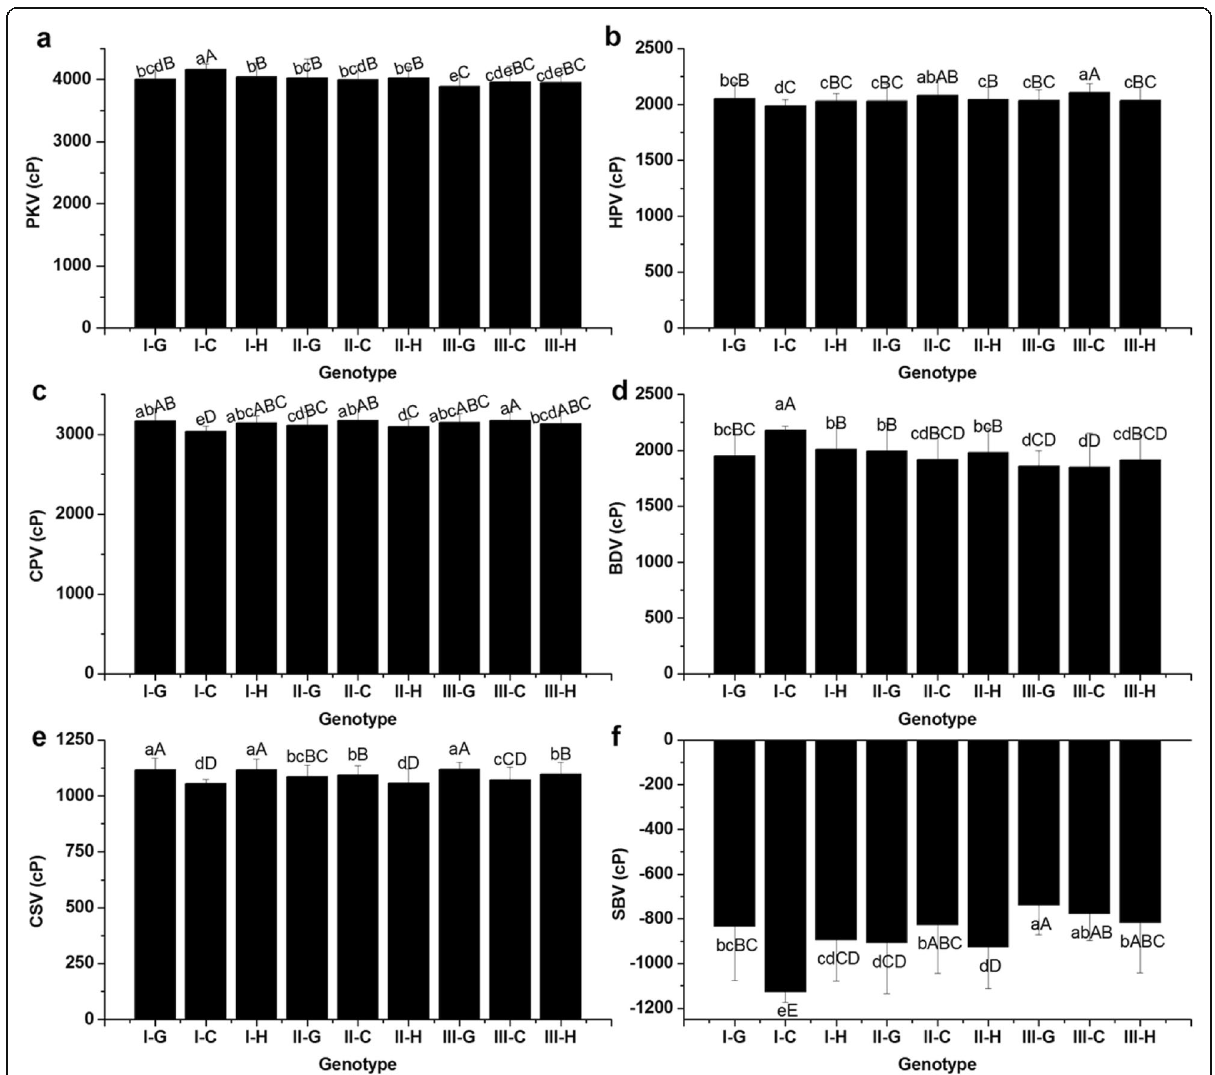
Fig. 4 Comparison of RVA profile characteristics for different combinations of SSIV-2 × AGPlar . a Peak viscosity (PKV); b Hot paste viscosity (HPV); c Cool paste viscosity (CPV); d Breakdown viscosity (BDV); e Consistence viscosity (CSV); f Setback viscosity (SBV); Type I, II and III indicate homozygous for GZ63S, CG173R and heterozygote in AGPlar locus, respectively; Type G, C and H represent homozygous for GZ63S, CG173R and heterozygote in SSIV-2 locus, respectively; Each column represents the mean ± standard deviation. Lowercase and capital letters above column denote significant at 0.05 and 0.01 levels. Each sample was repeated